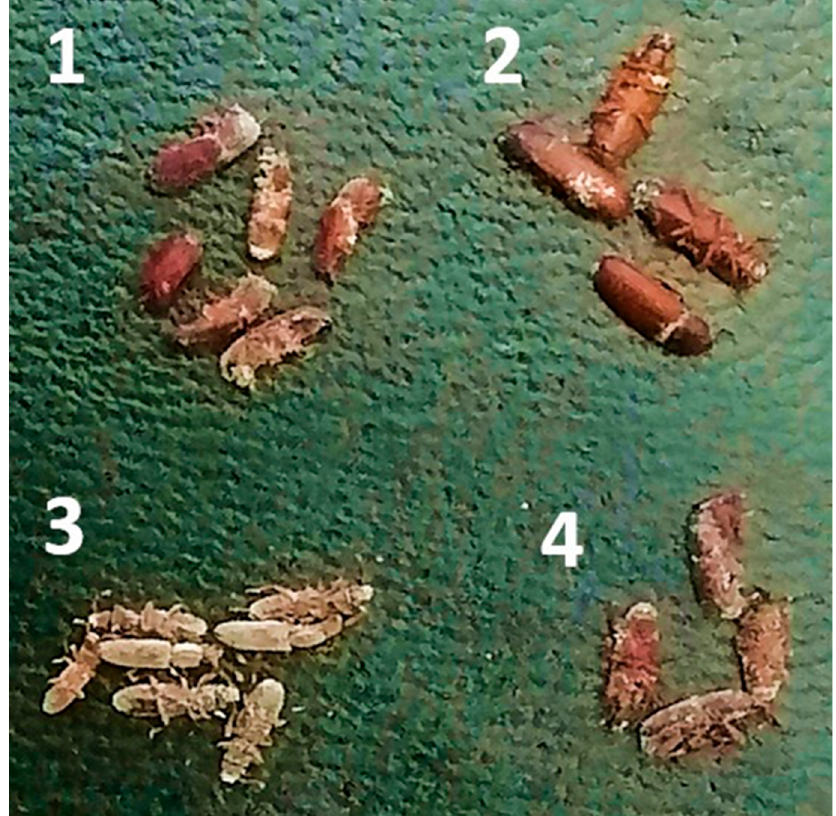
Figure 6. Morphological effect and mortality of SiO 2 -NPs on the four stored products insects i.e., ( 1 ) T. castaneum, ( 2 ) R. dominica , ( 3 ) O. surinamenisis and ( 4 ) S. oryzae showing that SiO 2 -NPs covering the insects and caused death.